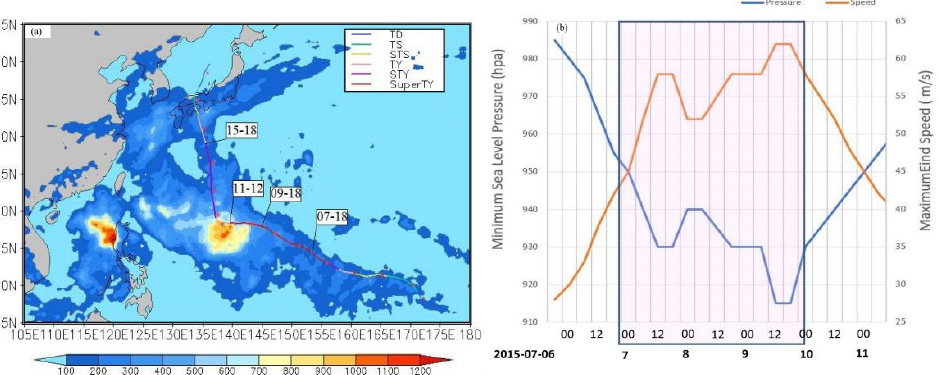
Figure 1. ( a ) The track and intensity of Typhoon Nangka and accumulated precipitation distribution during the typhoon life cycle (the track is indicated by the curve and the intensity is the color of the curve labeling at upper right; the precipitation is shown as a shaded area and scaled below with unit mm), and ( b ) the evolution of minimum central pressure (blue curve, hPa) and near-central maximum wind speed (yellow curve, m·s − 1 ). TD denotes the tropical depression, TS denotes the tropical storm, STS denotes the severe tropical storm, TY denotes the typhoon, STY denotes the severe typhoon and SuperTY denotes the super typhoon. The shaded area in panel ( b ) represents the situation of the study period in this research.